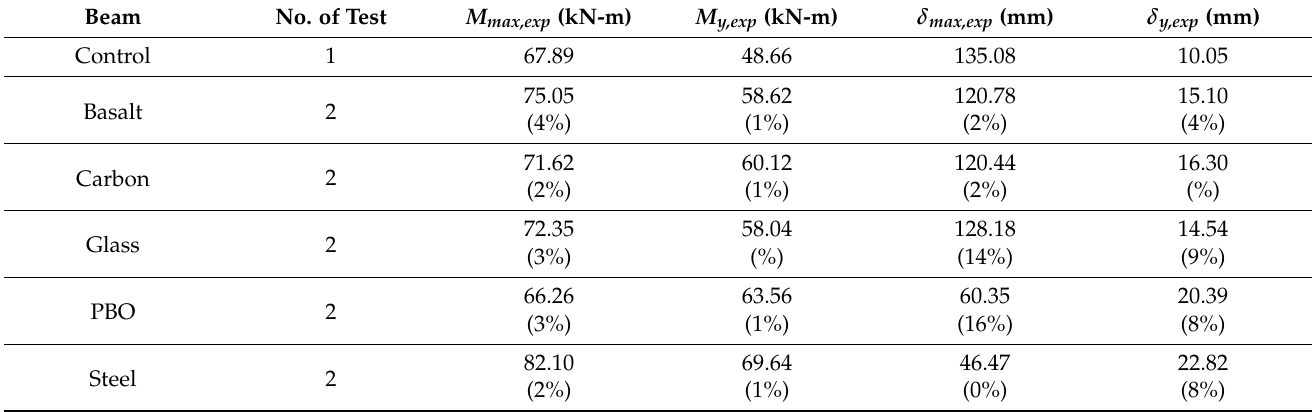
Table 3. Experimental results of the bending